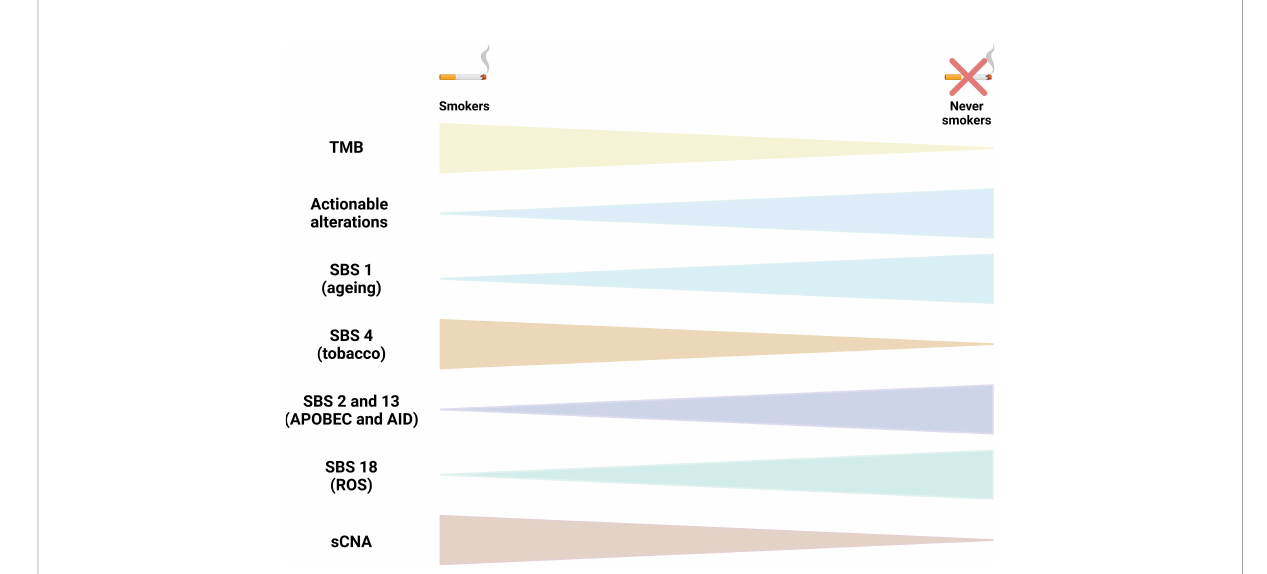
FIGURE 1 Molecular characteristics of lung cancer in non smokers (LCINS). The fi gure compile the recurrent molecular characteristics reported in studies that used whole exome sequencing (WES) and whole genome sequencing (WGS) to identify mutational processes end genomic characteristics in LCINS. Triangles tips point to the direction of the less frequent or less abundant alteration. TMB, tumor mutational burden; SBS, single base substitution mutational signature; sCNA, somatic copy number alterations; ROS, reactive oxygen